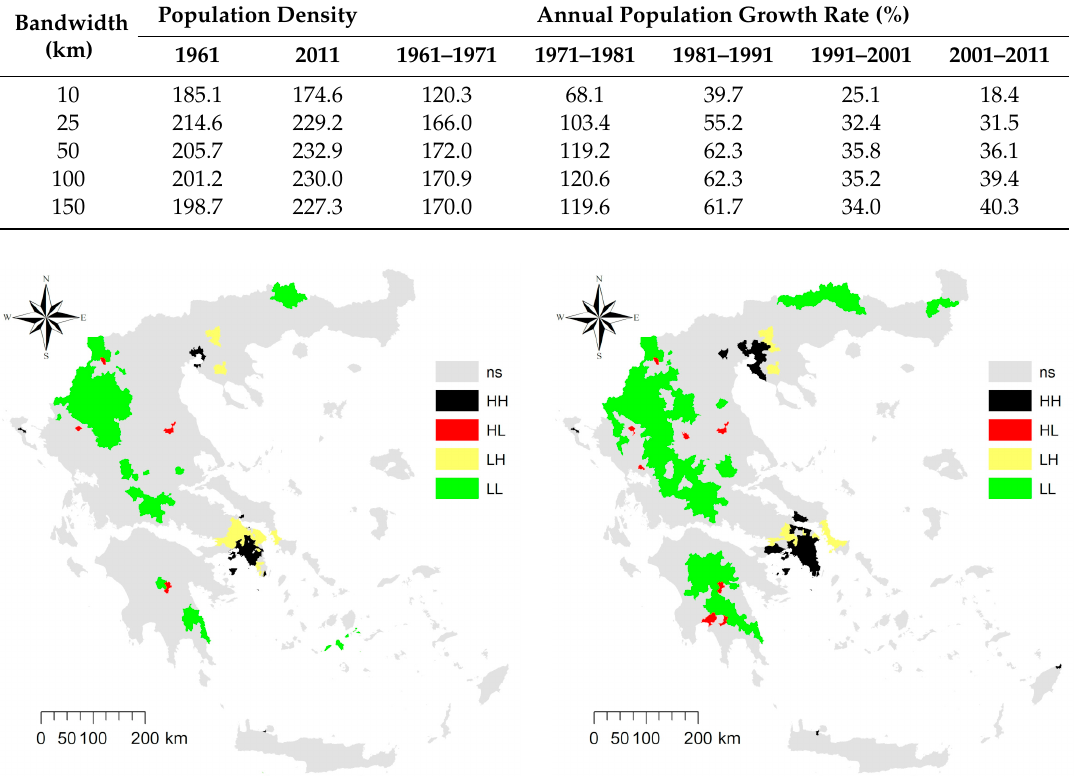
Figure 4. Maps illustrating spatial clustering of population density in Greece (left: 1961; right 2011; HH: High–High hotspots, HL: High–Low coldspots, LH: Low–High coldspots, LL: Low–Low hotspots, ns: non-significant).